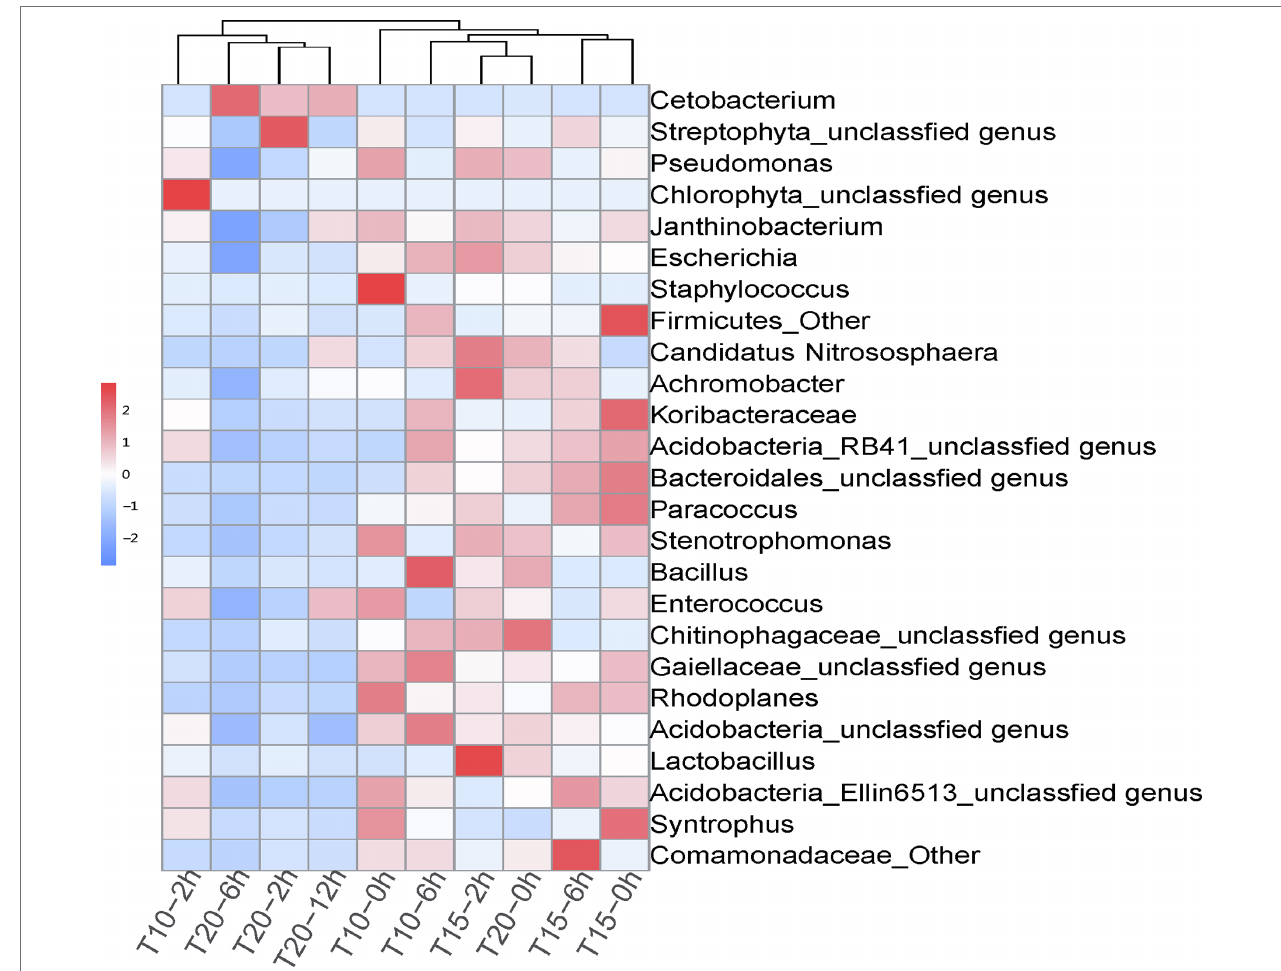
FIGURE 4 | Correlation heatmap of dominant intestinal bacterial genera in juvenile O. stewarti samples during heat stress. T10, T15, and T20 indicate 10 ° C, 15 ° C, and 20 ° C acclimation temperature backgrounds of the experiment fish; 0, 2, 6, and 12 h represent the duration of the heat